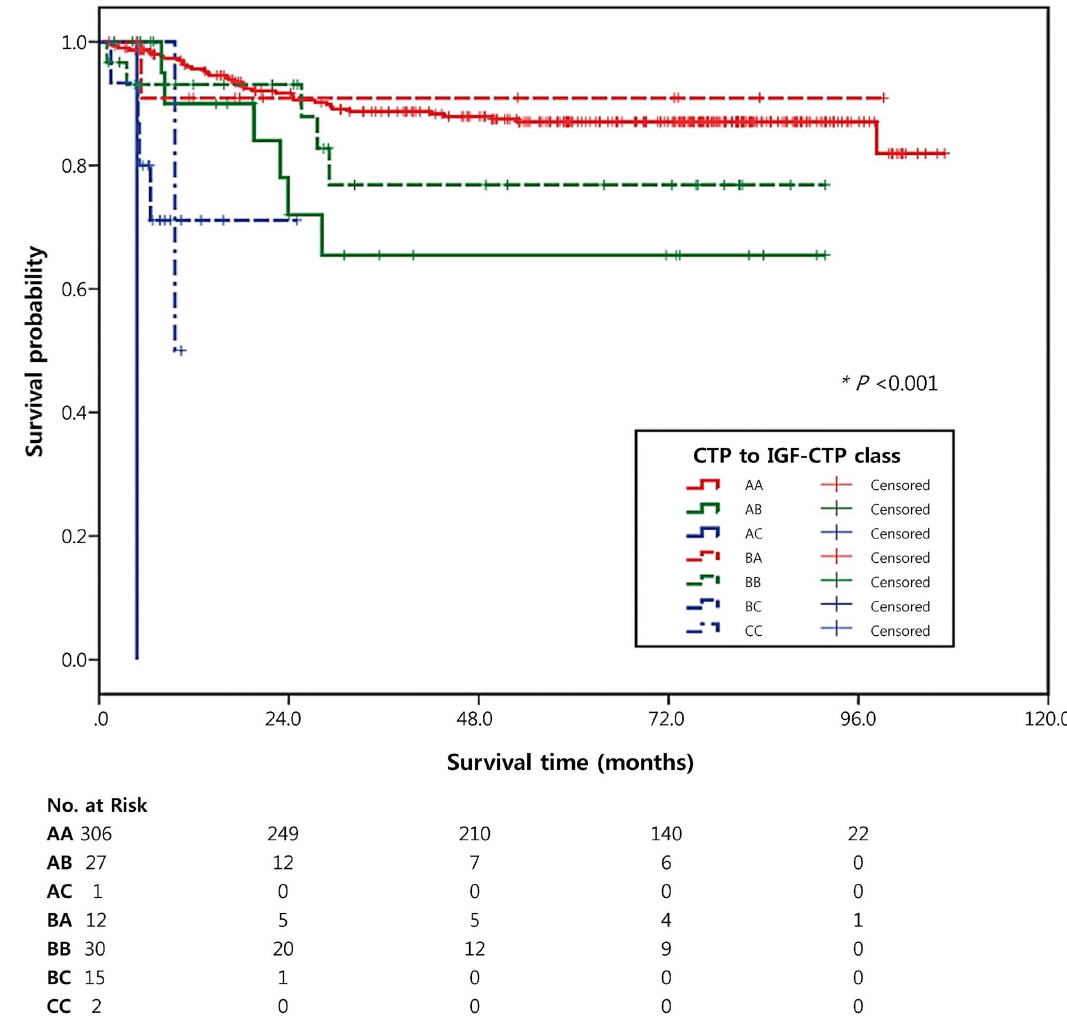
Fig 2. Kaplan-Meier survival curves of patients according to CTP class and IGF-CTP class. Tables beloweach graph show the numbers of patients at risk at various time points.